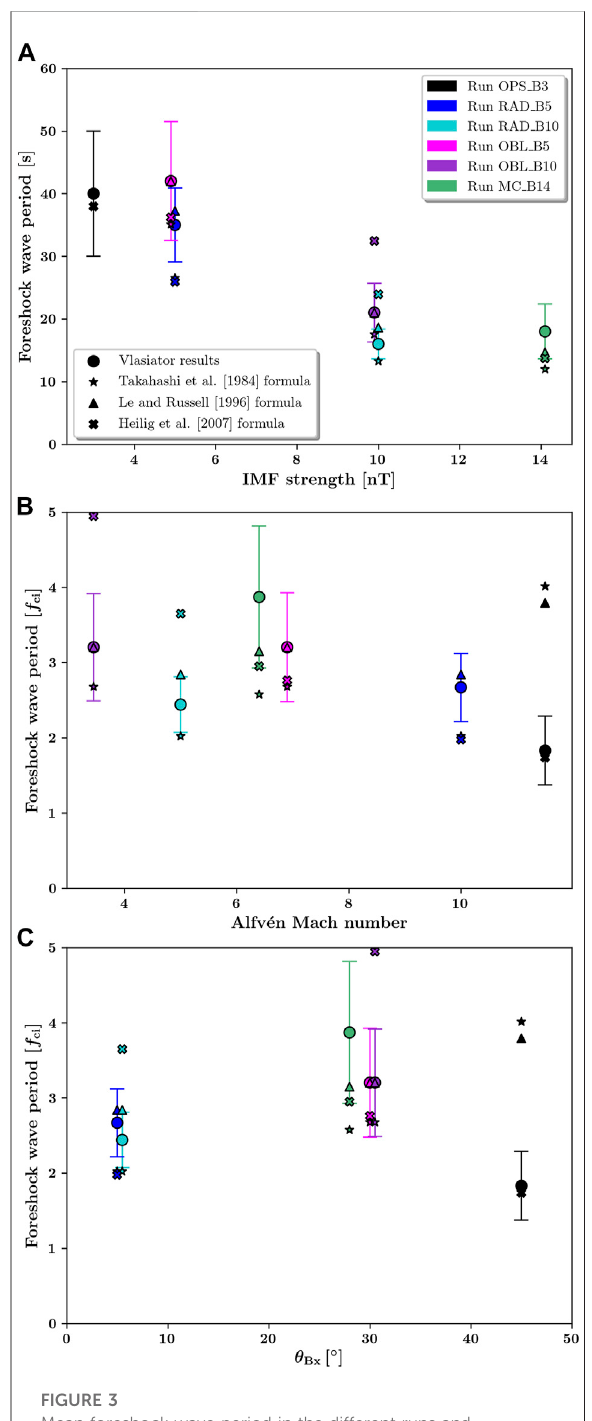
FIGURE 3 Mean foreshock wave period in the different runs and predictions from the Takahashi et al. (1984) (Eq. 2), Le and Russell (1996) (Eq. 1) and Heilig et al. (2007) (Eq. 3) formulae, as a function of (A) the IMF strength, (B) the Alfvén Mach number and (C) the cone angle θ Bx . The error bars for the simulation results correspond to one standard deviation of the wave period. The wave periods are given in seconds in panel (A) and are normalised with the proton gyrofrequency f ci = qB /(2 π m p ) (with q the proton charge and m p the proton mass) in panels (B) and (C) in order to